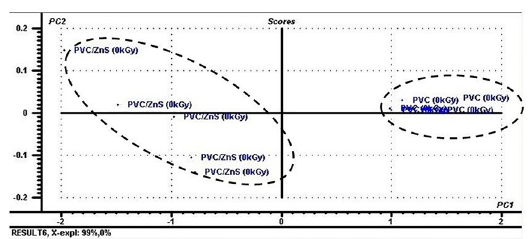
Figure 7. Score plots of PC1 x PC2 of PVC and PVC/ZnS films.